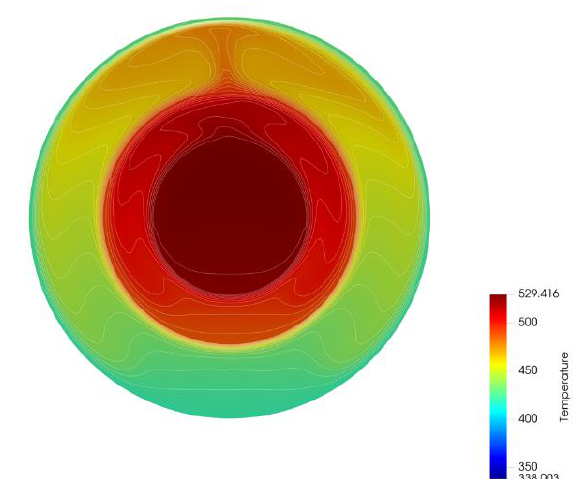
Fig. 3. Temperature field after 15 minutes .